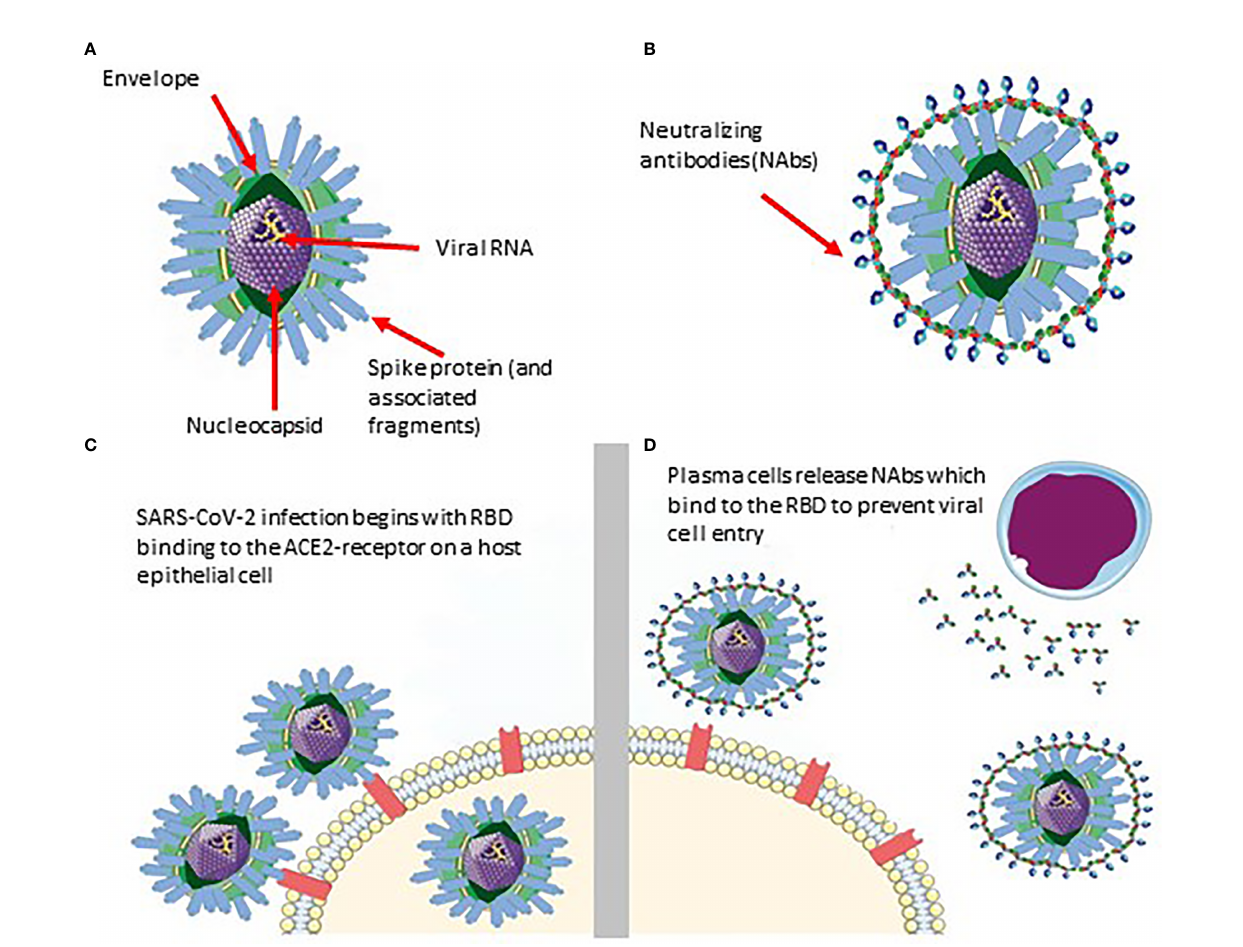
FIGURE 1 | Schematic of SARS-CoV-2 in fi ltration and neutralization. (A) SARS-CoV-2 viral structure. (B) Neutralizing antibodies developed against SARS-CoV-2. (C) In fi ltration of SARS-CoV-2 into the host cell via RBD binding. (D) Neutralizing antibodies bind speci fi cally to a SARS-CoV-2 epitope (RBD in this case) to prevent it from entering the epithelial